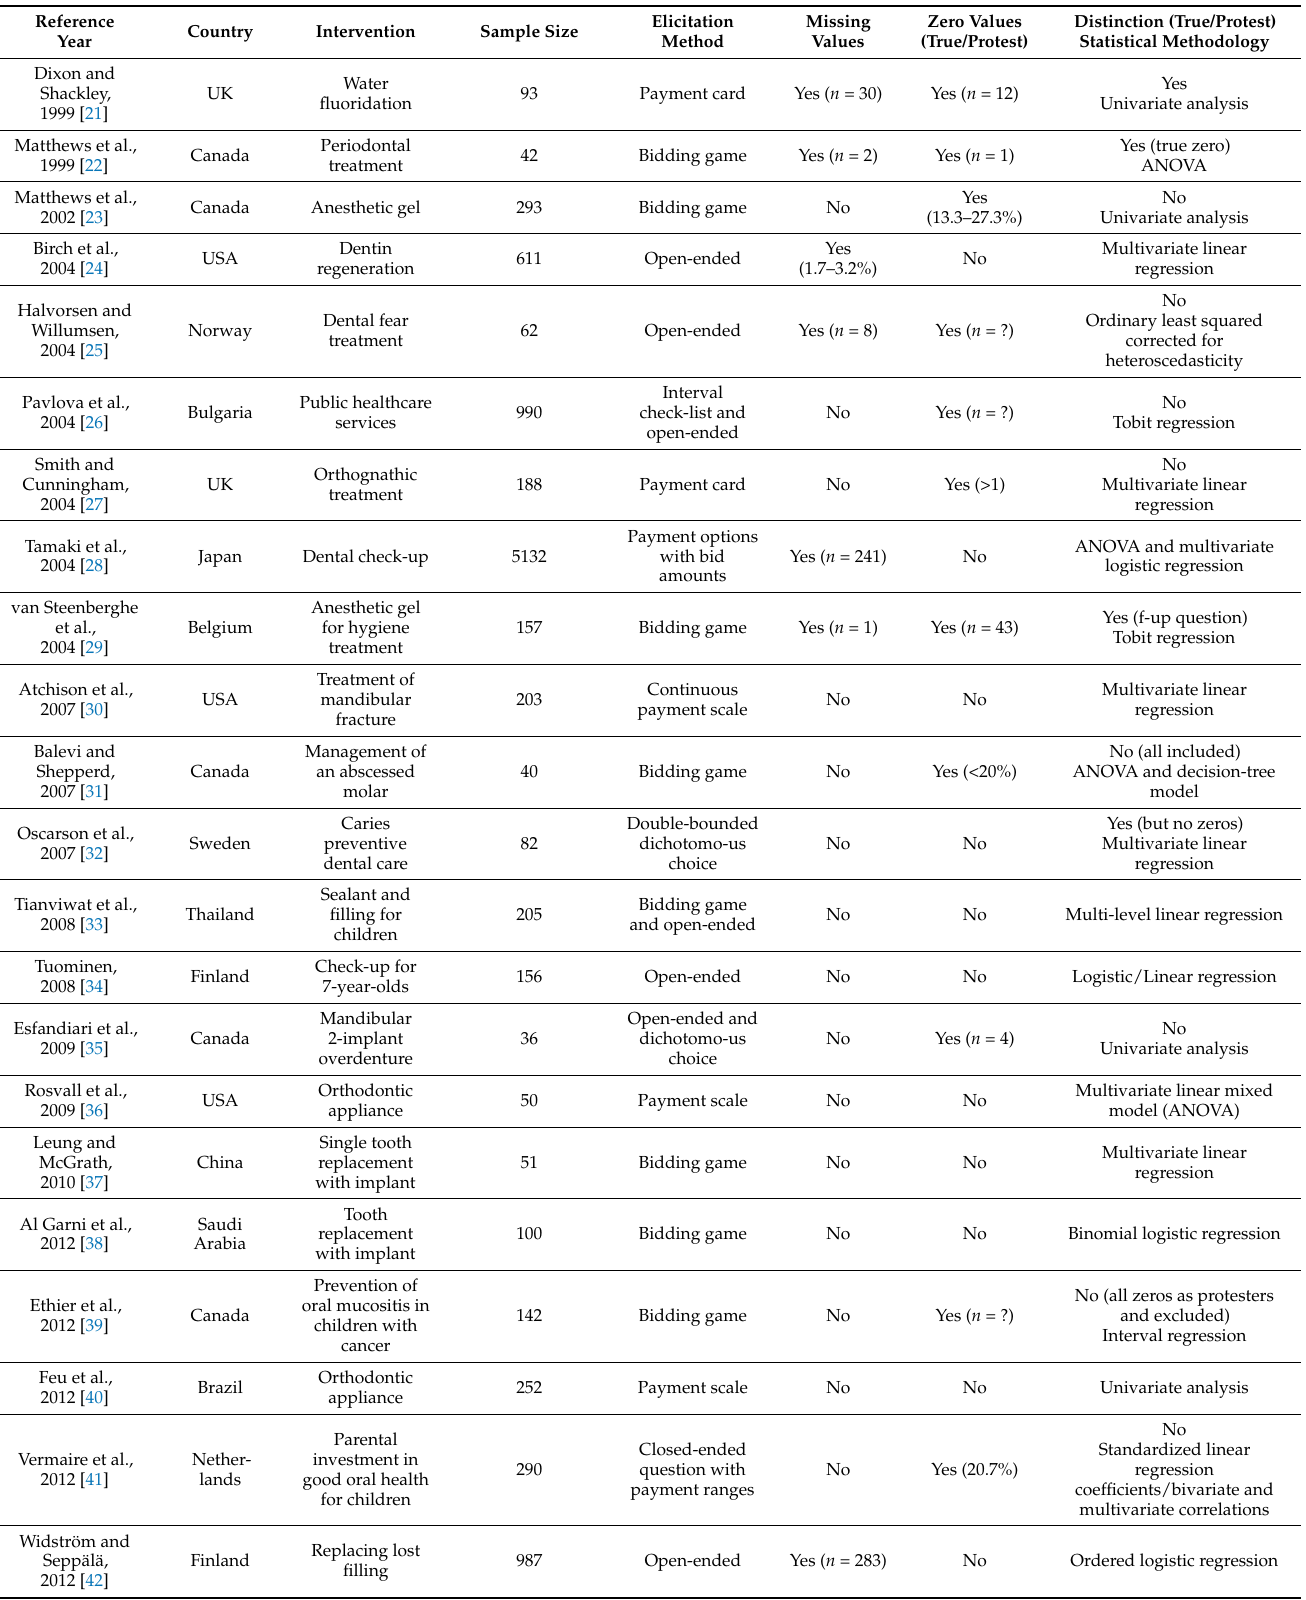
Table 1. Contingent valuation willingness-to-pay studies included in review (sorted by date of